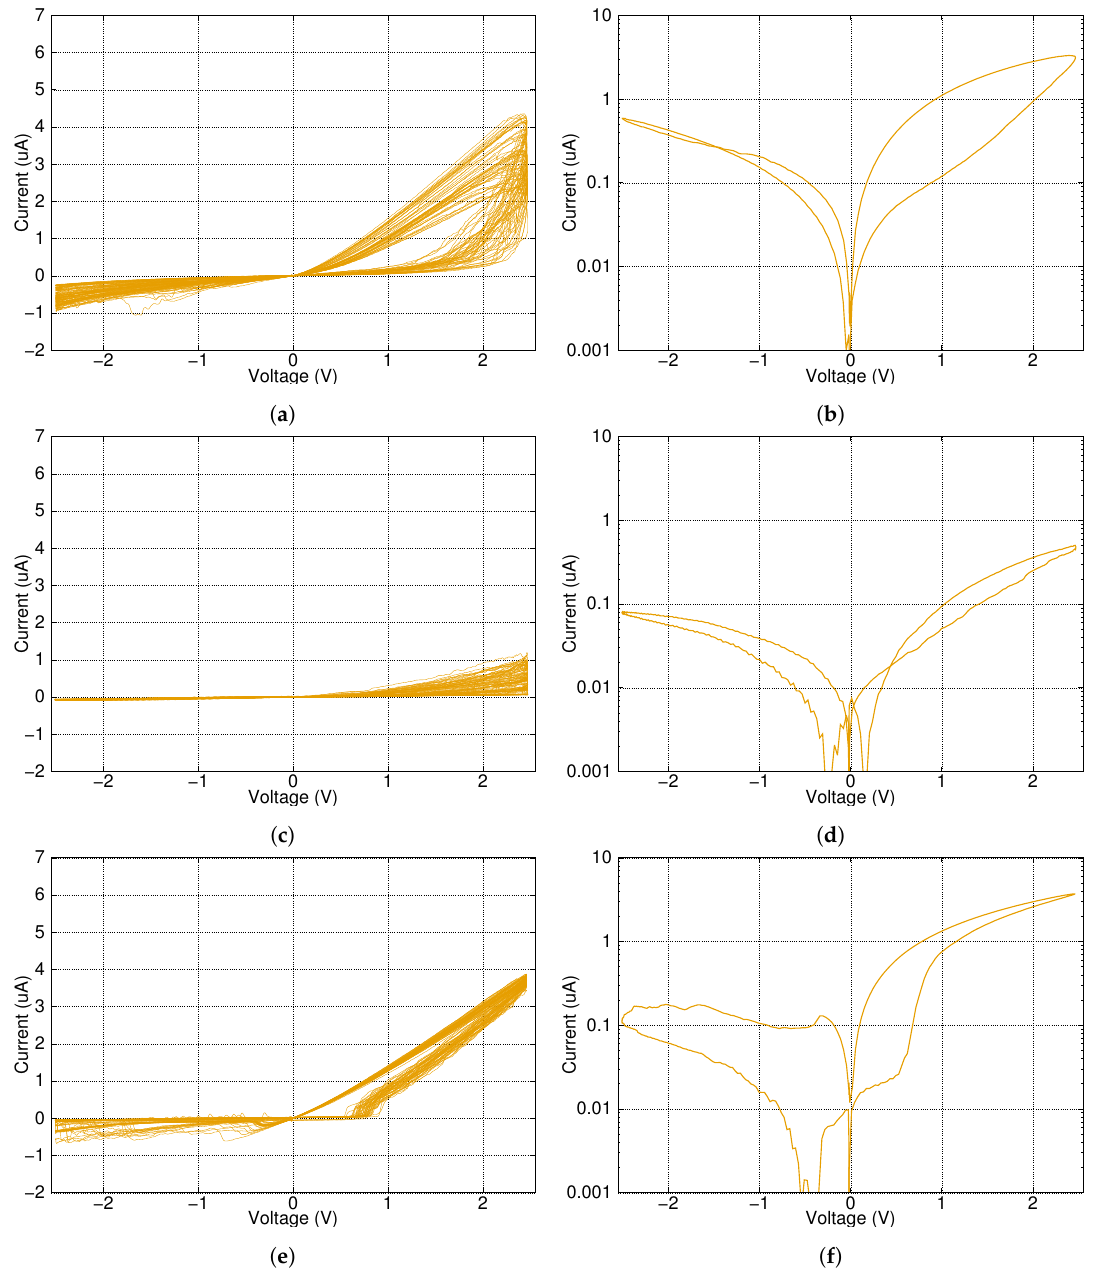
Figure 6. Short-time pulses on a single memristor, the checkerboard like and the H-fractal memristor network, respectively. ( a , c ) and ( e ) show the voltage–current diagram of the whole signal. ( b , d , f ) are the average of all 50 write–erase signals on a logarithmic